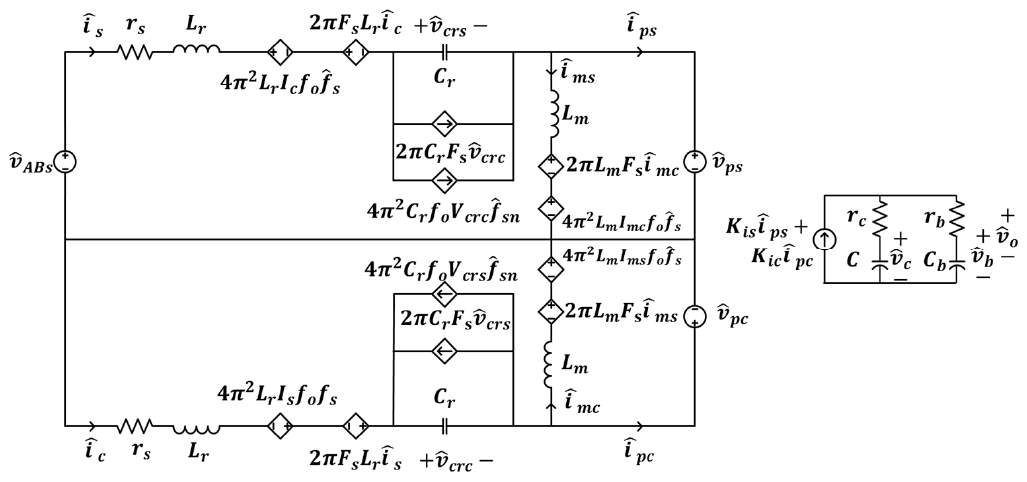
Figure 6. Small signal model of LLC resonant converter.